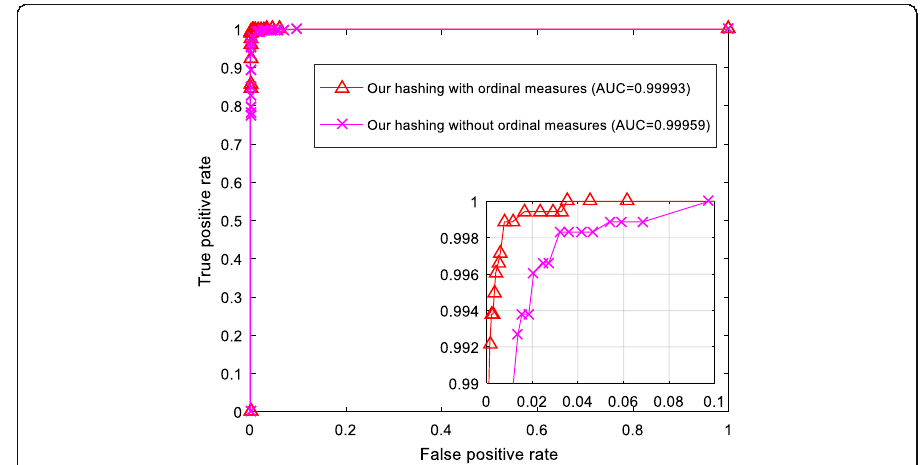
Fig. 10 ROC curve comparison between our hashing with ordinal measures and our hashing without ordinal